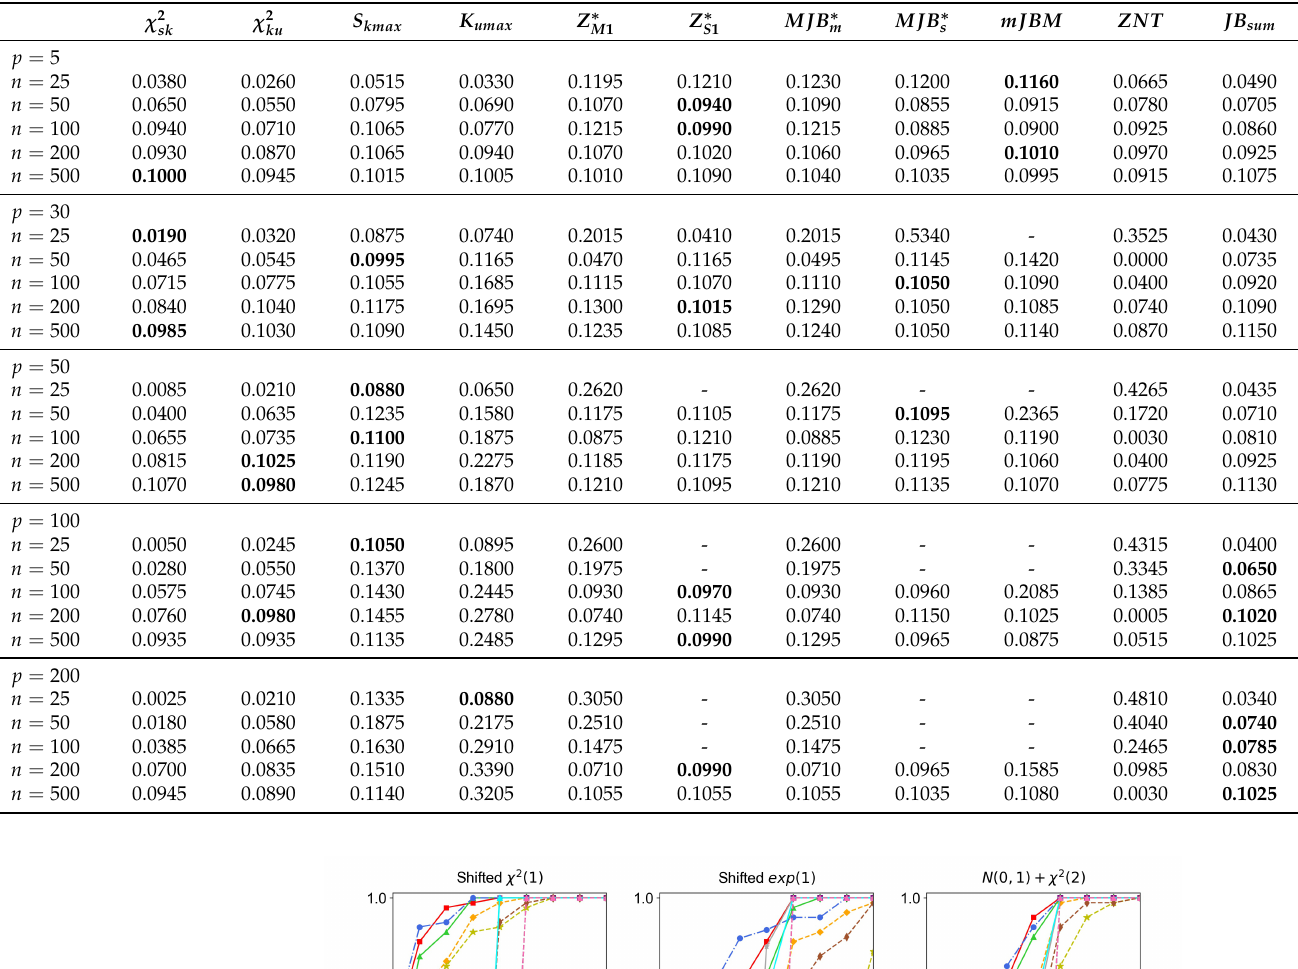
Table 6. Empirical power of PC-type Jarque–Bera (JB) testing for normally distributed data for Case-II compared with other methods ( α = 0.1).